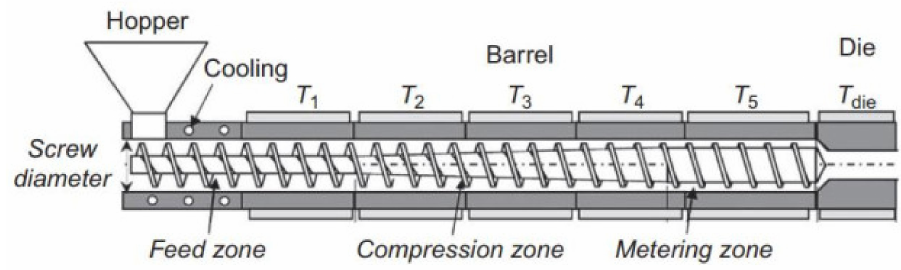
Figure 2. Schematic of a conventional extruder—single screw extruder. Reprinted from Covas, J., & Hilliou, L. (2018). Chapter 5—Production and Processing of Polymer-Based Nanocomposites. In M. Â . P. R. Cerqueira, J. M. Lagaron, L. M. P. Castro, & A. A. M. de O. S. Vicente (Eds.), Nanomaterials for Food Packaging (pp. 111–146) [10]. Copyright (2018), with permission from Elsevier.